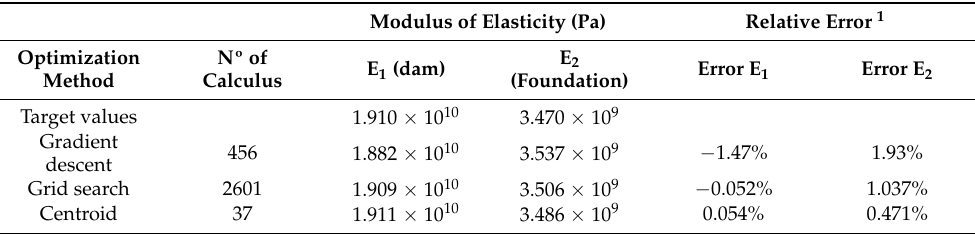
Table 5. Comparison of the results of the different methodologies employed. Dam and homoge- neous foundation.